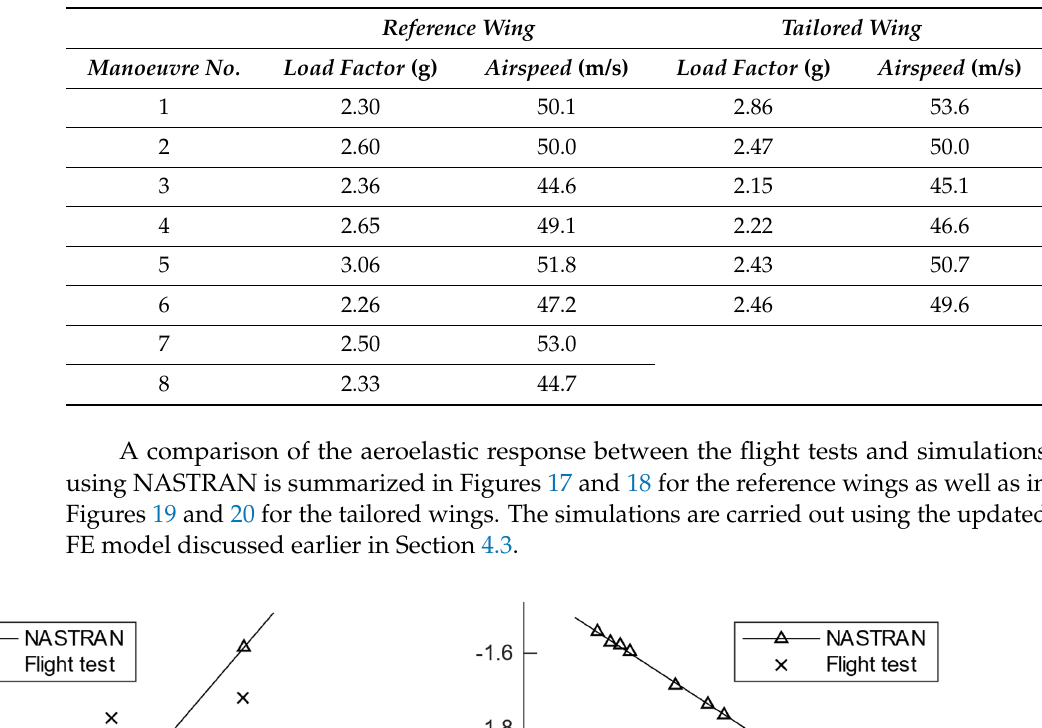
Table 4. Test flight manoeuvres for reference and tailored wings.